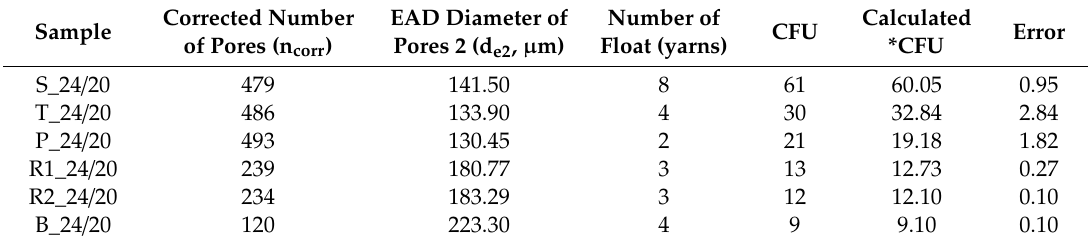
Table 9. Multiple linear regression of samples with a density of 24 /